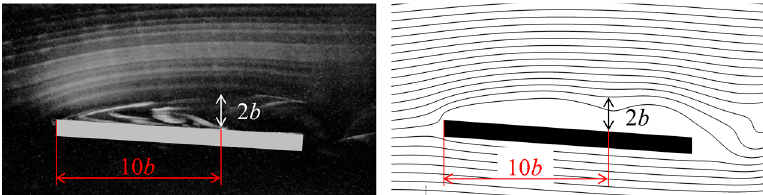
Figure 6. Visualized flow field in experiment and predicted streamline for a fixed plate with α = 4°.